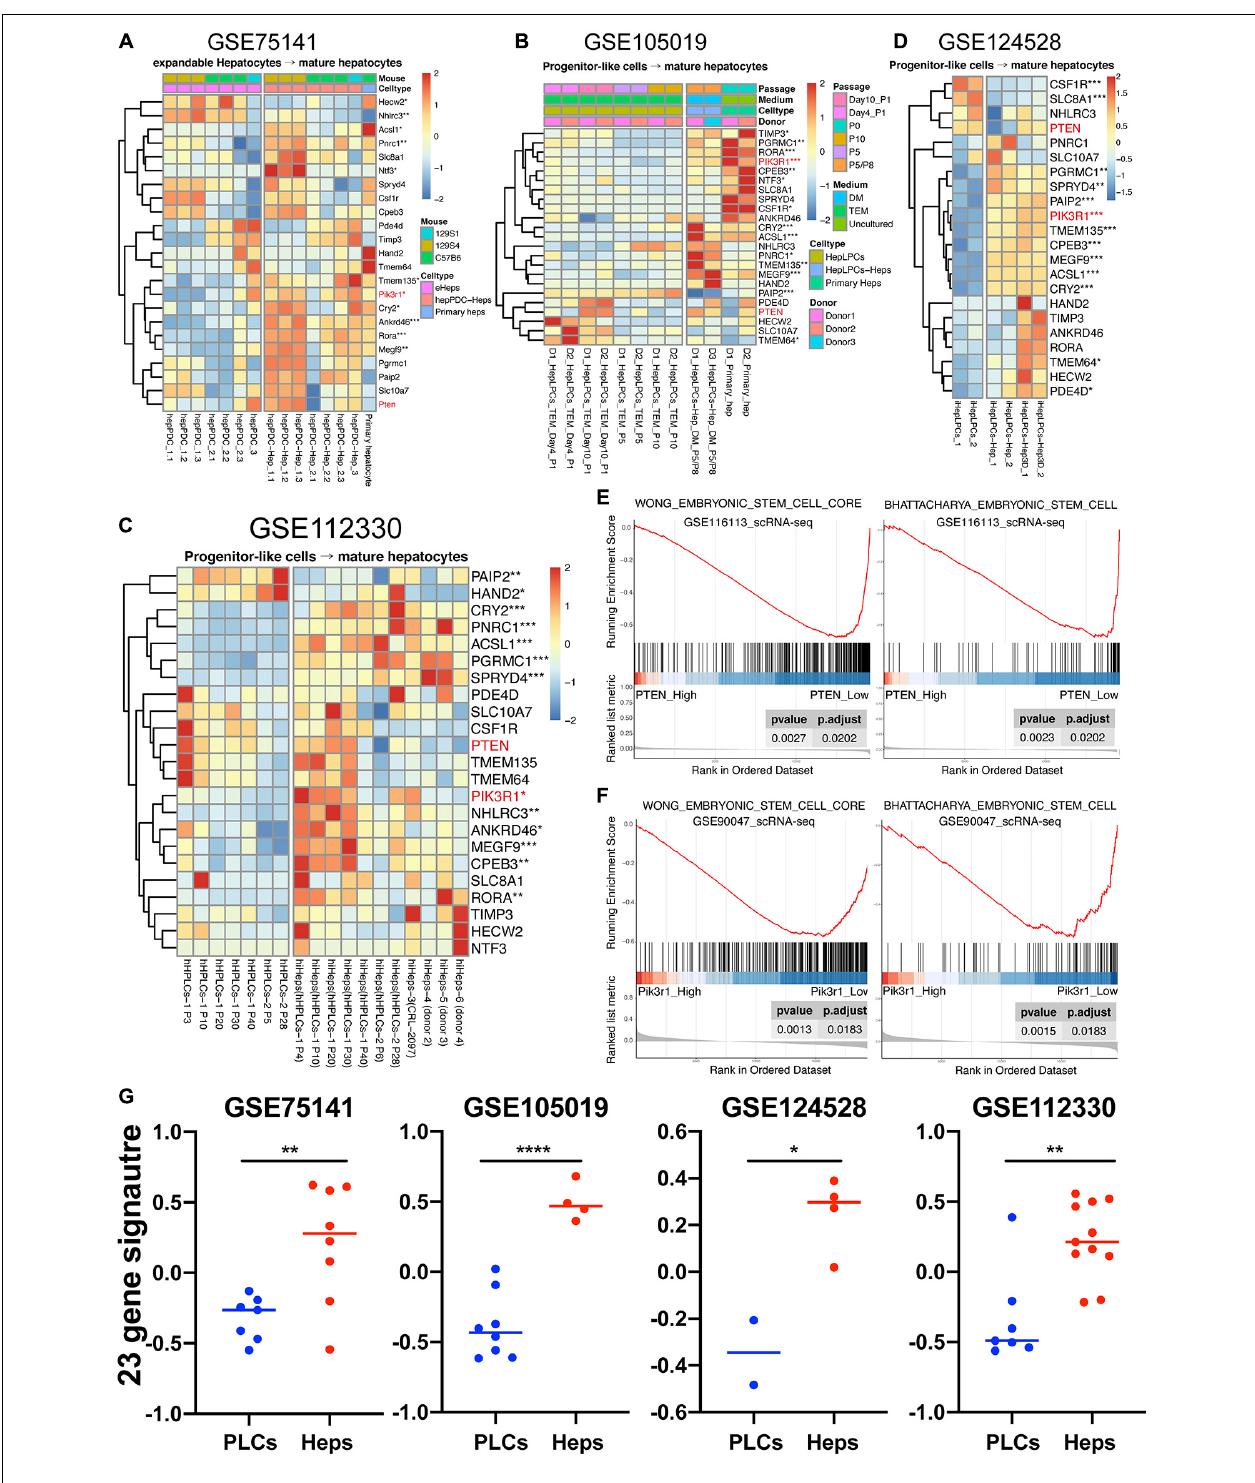
FIGURE 7 | Highly expressed tendency of 23 genes in mature hepatocytes compared to liver progenitor-like cells. (A–D) hepPDC, hepatocyte-derived proliferative duct-like cell; hepPDC-Hep, hepPDC-derived hepatocyte; eHeps, expandable hepatocytes; heps, hepatocytes; HepLPCs, hepatocyte-derived liver progenitor-like cells; P, passage; hHPLCs, human progenitor-like cells; hiHeps, human induced hepatocytes; iHepLPCs, hepatocyte-induced liver progenitor cells. iHepLPCs-Hep3D, iHepLPCs organoid. (E) GSEA analysis of single cell datasets (GSE116113) based on PTEN expression. (F) GSEA analysis of single cell datasets (GSE90047) based on Pik3r1 expression. (G) GSVA analysis of 23-gene signature across the datasets with enough samples. * P < 0.05, ** P < 0.01, *** P < 0.001, and *** P < 0.0001.